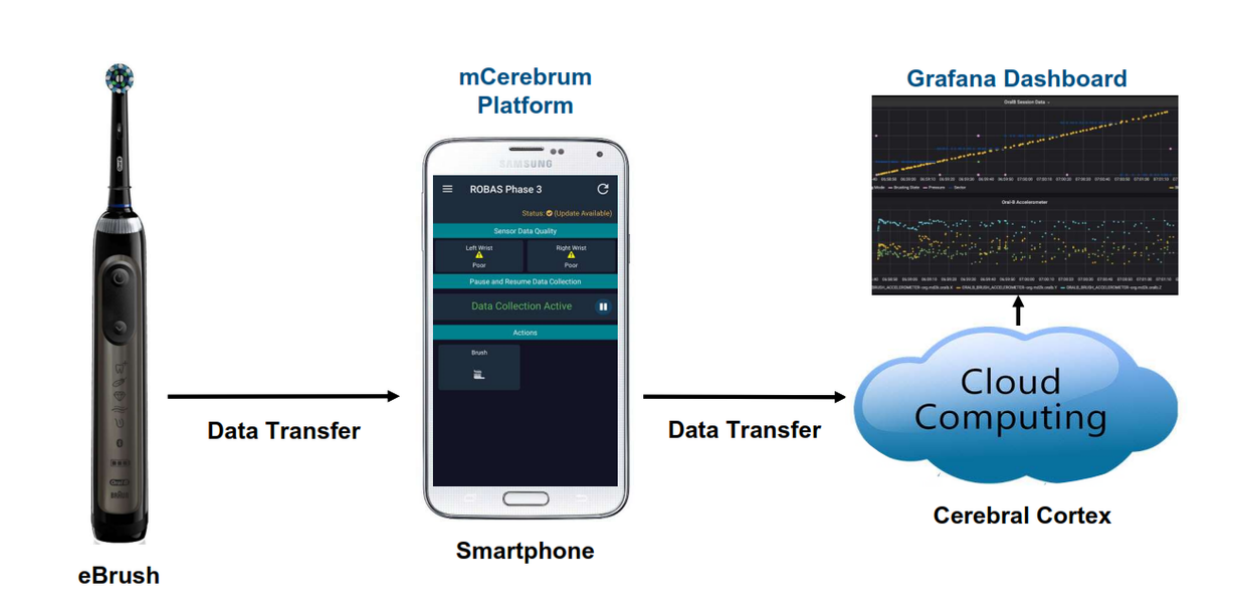
Figure 1. Brushing data generated by the electronic brush (eBrush) collected by a smartphone app and transmitted to a computing cloud for analysis and monitoring.